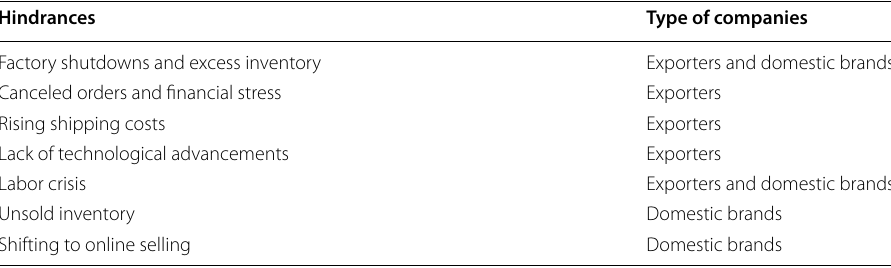
Table 2 Problems faced by